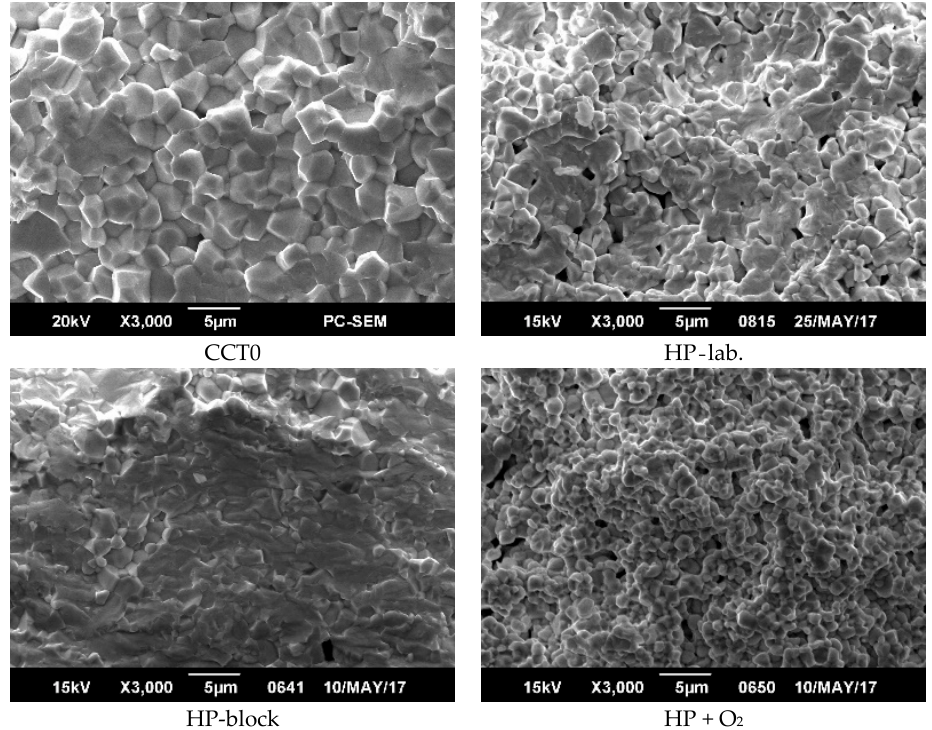
Figure 2. Fragments of microstructures of SS ceramics, produced by CCT0, HP-lab, HP-block and HP + oxygen. Table 1. Parameters = 𝑎 and 𝑐 ; volume = 𝑉 ; degree of distortion = 𝑐/𝑎 ; for tetragonal cells, homogeneous strain parameter = 𝛿 ; experimental = 𝜌 (cid:3032)(cid:3051)(cid:3043). ; X-ray = = 𝜌 (cid:3051)(cid:2879)(cid:3045)(cid:3028)(cid:3052) ; and relative = 𝜌 (cid:3045)(cid:3032)(cid:3039) , densities of PCR-13 produced by different methods.